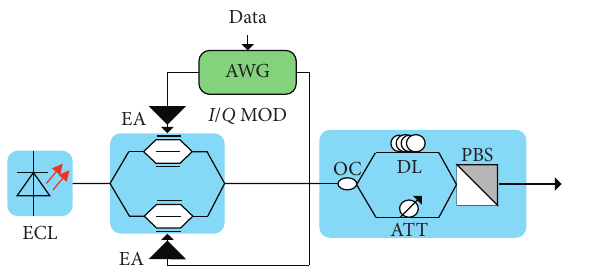
Figure 12: Schematic diagram of the optical baseband transmitter.